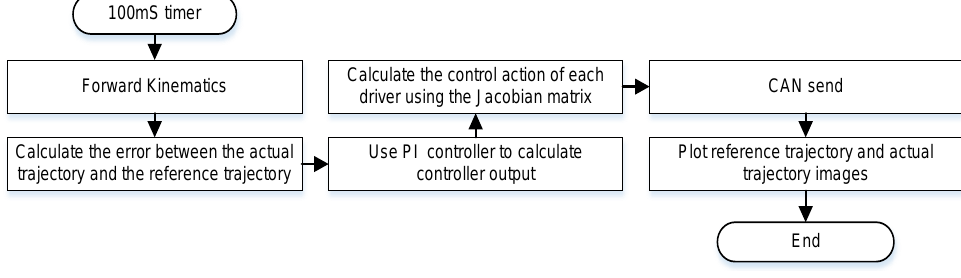
Figure 17. Flow chart of the trajectory closed-loop control program.